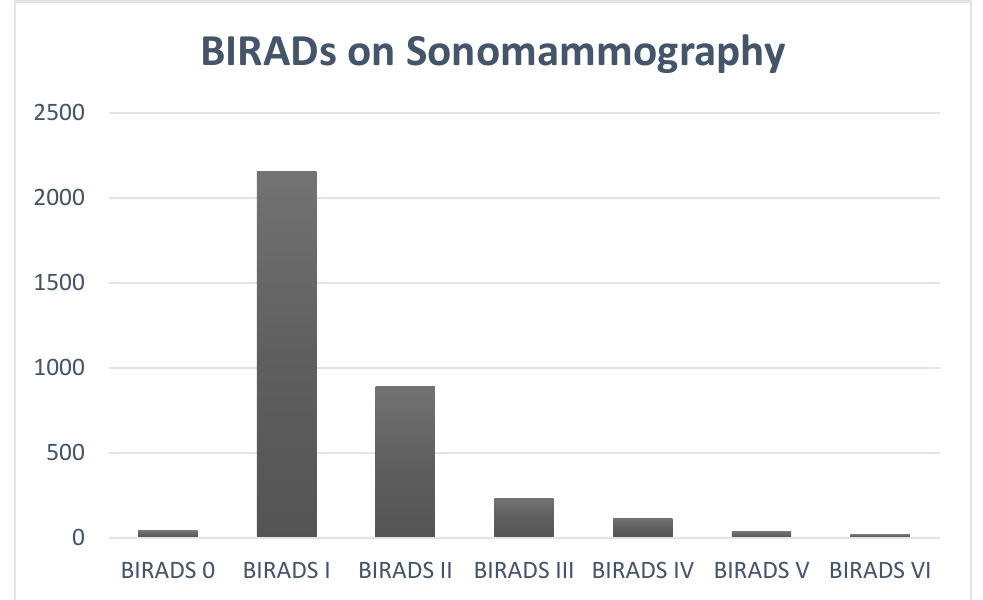
Figure 7. The BIRAD categorization on sonomammography.